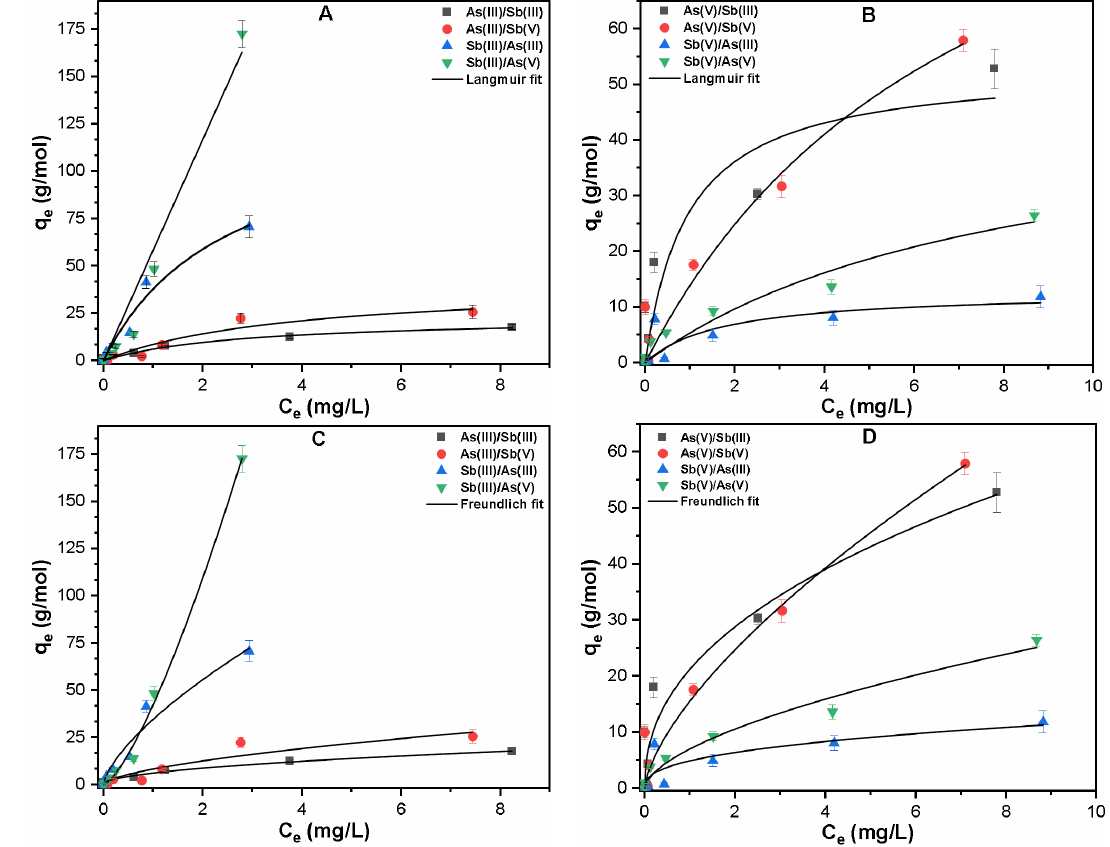
Figure 5. Under initial As and Sb concentrations of (0.1 to 10) mg/L, pH: 7 and 0.1 mM FC dose, showing ( A , B ) Langmuir; and ( C , D ) Freundlich fitting of the As and Sb coagulation data for the binary system.